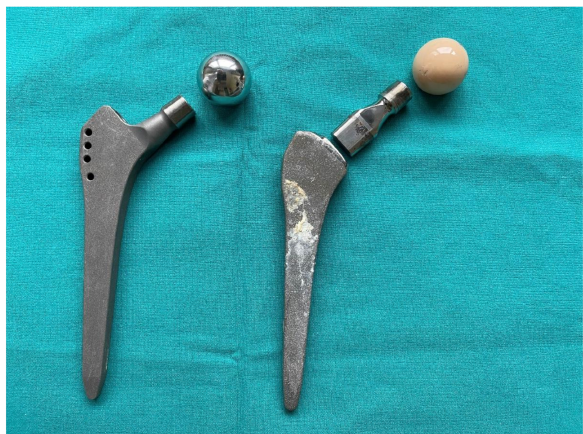
Figure 1. Monoblock ( left ) and dual modular femoral stems ( right ). Both stems could be fitted with separate heads of a different material, size, and bore length. The dual modular stem has been explanted 14 years after primary implantation at revision due to aseptic loosening of the acetabular component and massive proximal femoral bone loss.